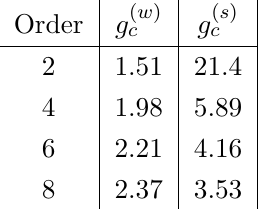
Table 3 . The first and second critical points, g ( w ) c and g ( s ) c , from resumming M 2 .